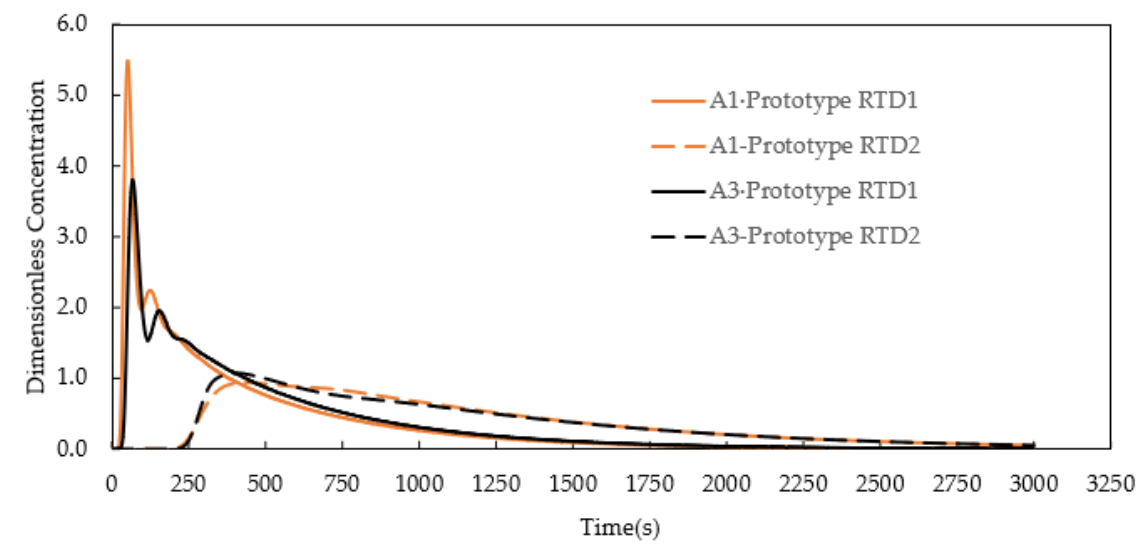
Figure 13. Calculated RTD curves by CFD modelling of Cases A1-Prototype and A3-Prototype. The data analysis of calculated RTD curves by CFD modelling are presented in Table 9.